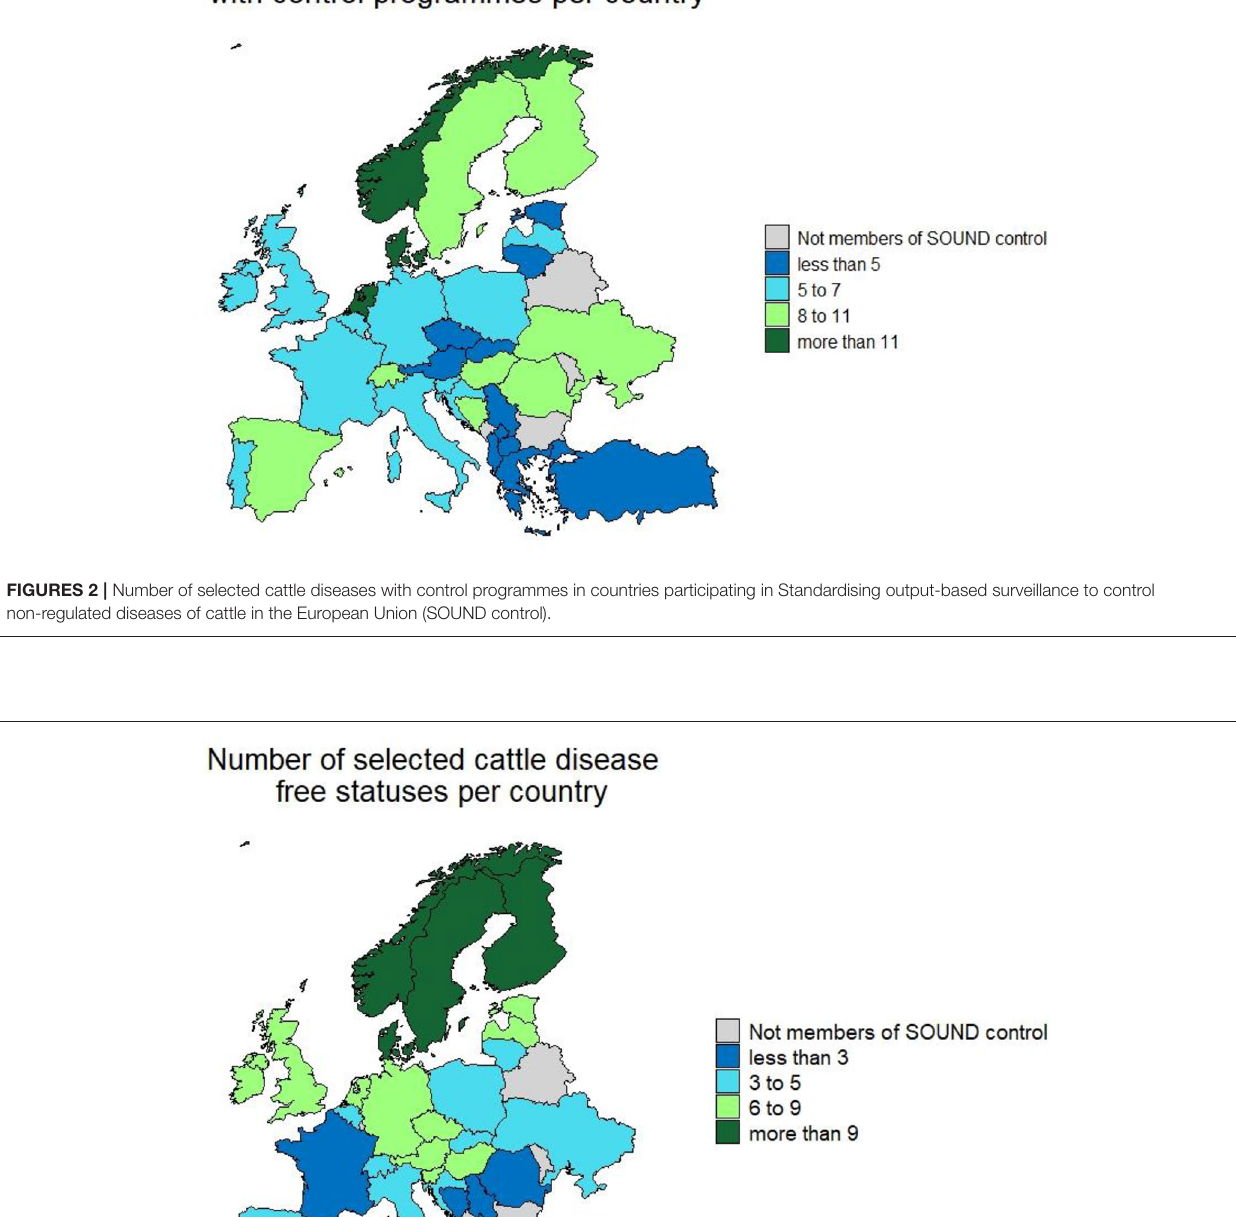
Frontiers in Veterinary Science |